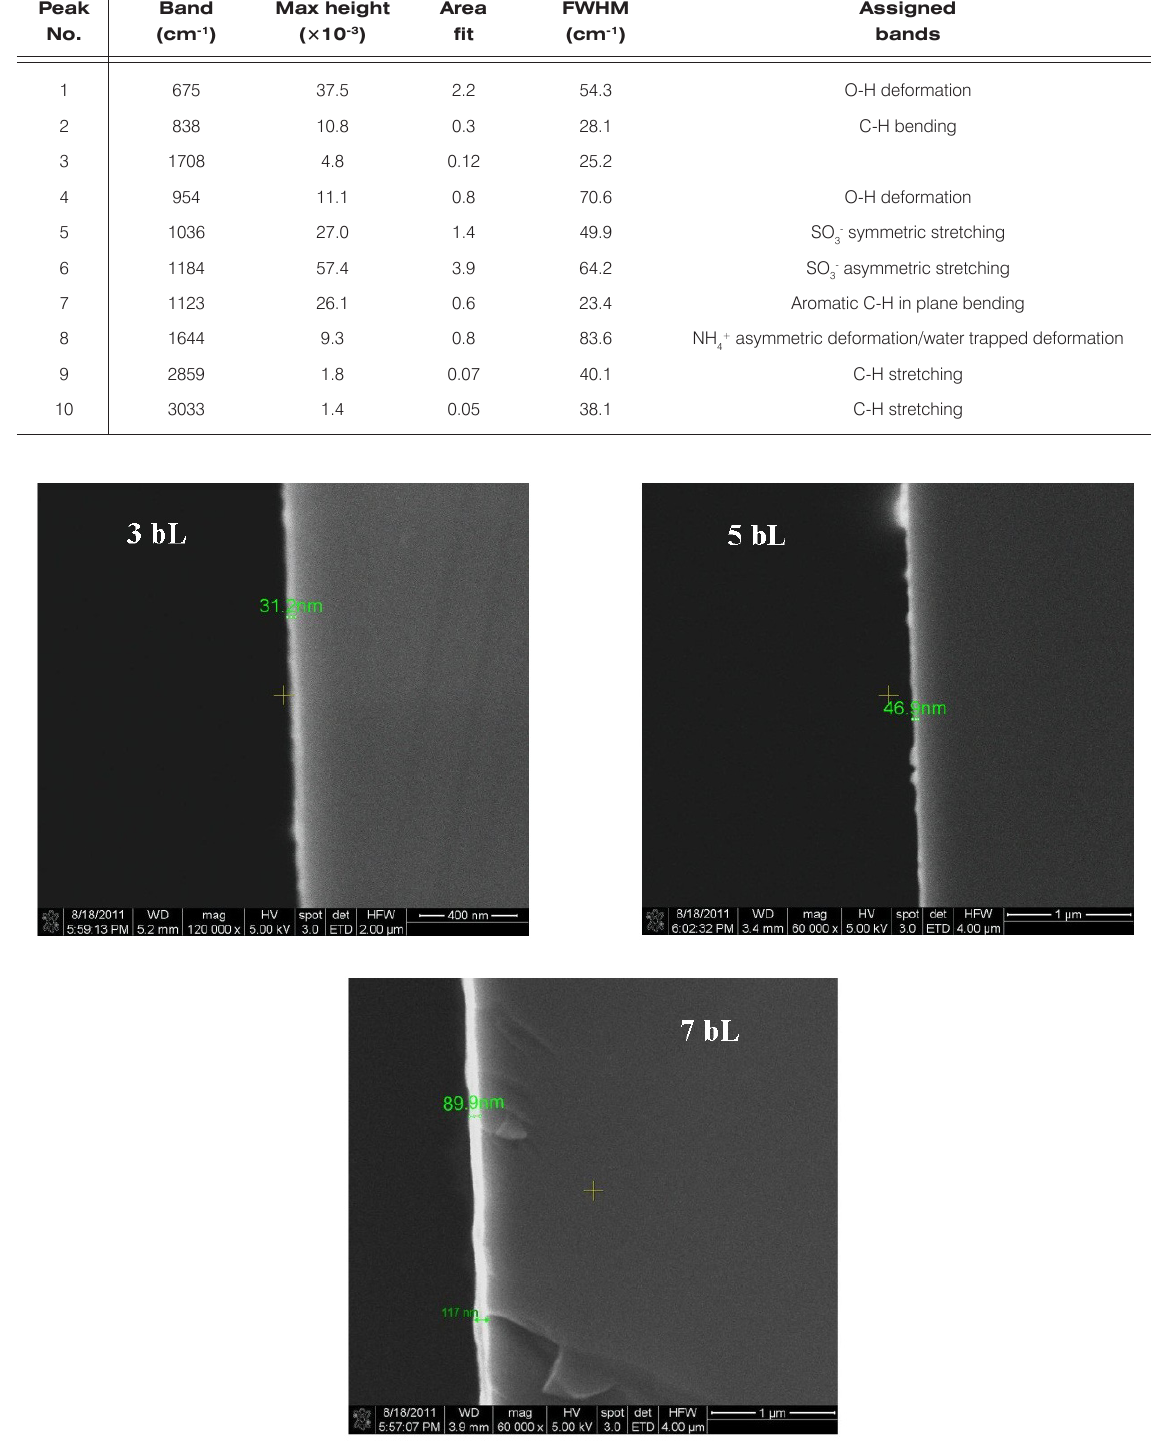
Figure 5. SEM images of the Si samples cross-section subjected to LbL deposition of 3, 5 and respectively 7 bilayers of